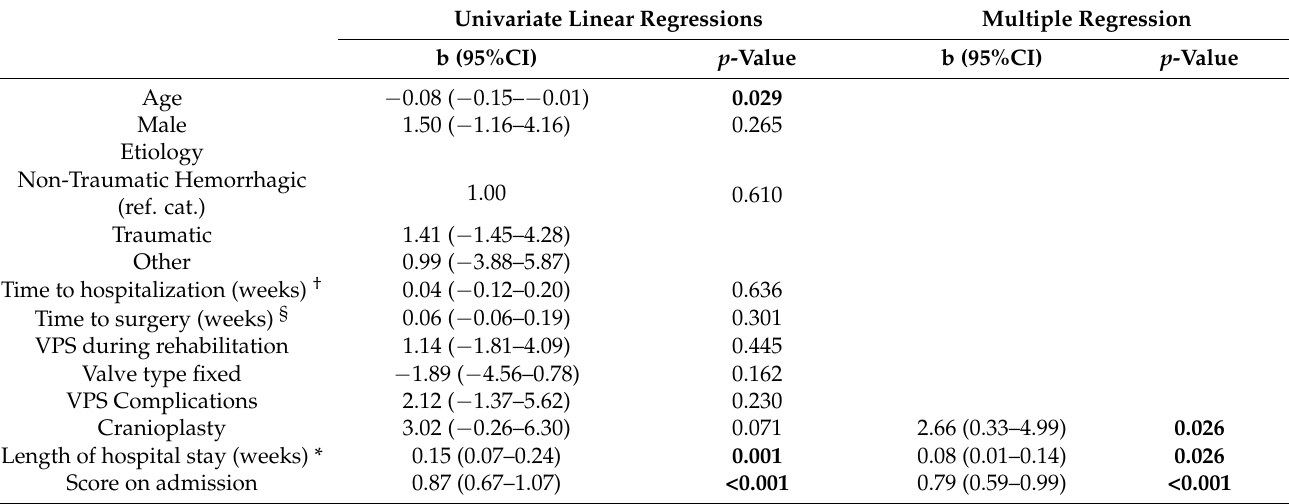
Table 5. Factors associated with DRS score at discharge: results from univariate and multiple linear regression analyses. Significant associations are shown in